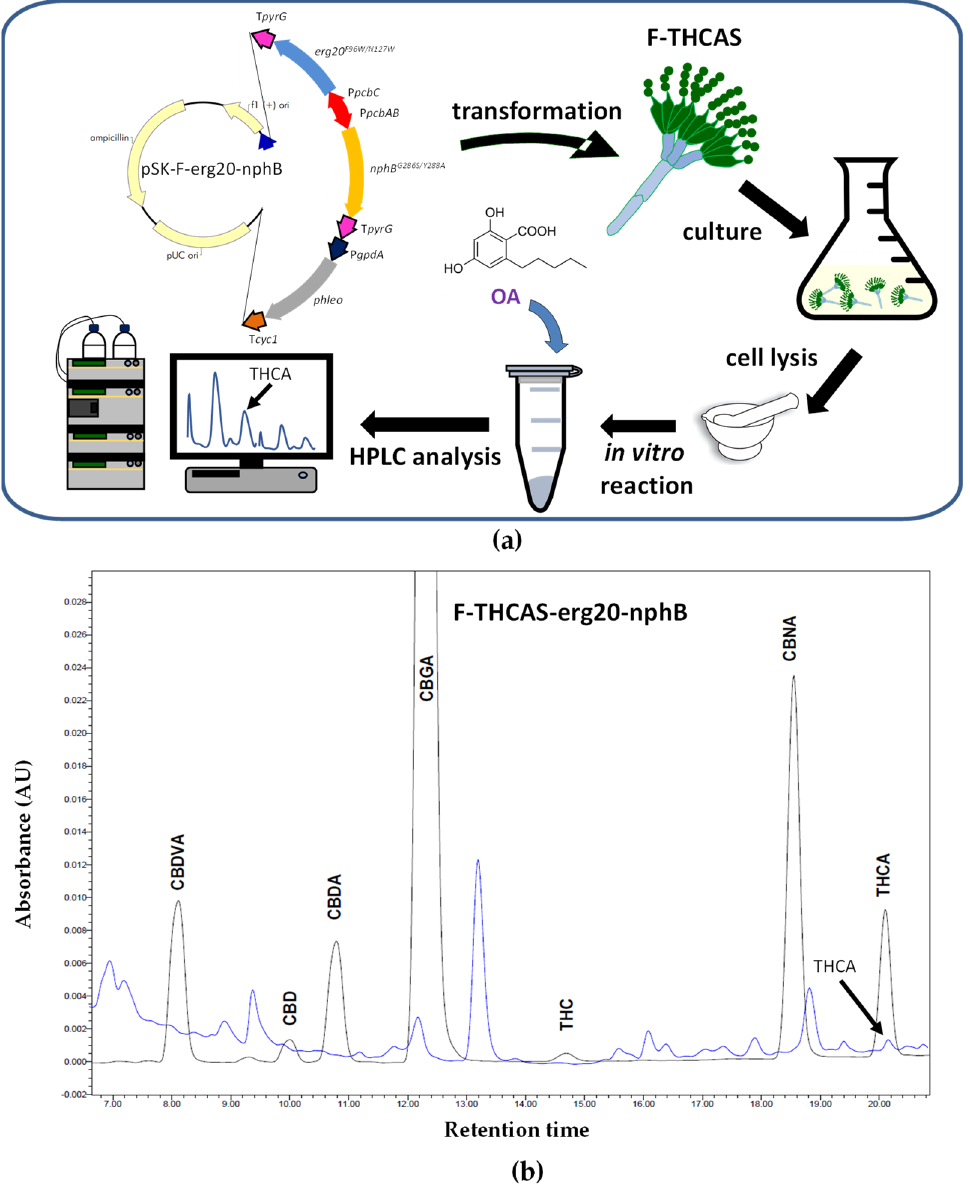
Figure 4. Production of ∆ 9 -THCA in P. chrysogenum lysates after the addition of OA. ( a ) Schematic representation of the strategy followed to produce ∆ 9 -THCA in P. chrysogenum F-THCAS. Plasmid pSK-F-erg20-nphB included: P pcbAB -P pcbC ( P. chrysogenum pcbAB-pcbC intergenic region), T pyrG (transcriptional terminator of the pyrG gene), erg20 F69W/N127W (mutant variant of the GPP synthase gene), P gpdA (promoter of glyceraldehyde-3-phosphate dehydrogenase (gpd) gene from A. nidulans ), cyc1 (transcriptional terminator of the S. cerevisiae cyc1 gene), nphB Y288A/G286S (mutant variant of the soluble aromatic prenyltransferase StNphB), and phleo (phleomycin resistance gene). ( b ) Chromatogram at 270 nm of one of the transformants of the F-THCAS-erg20-nphB strain showing the formation of ∆ 9 -THCA (blue line). Chromatogram peaks corresponding to standards of cannabinoids are included (black line).